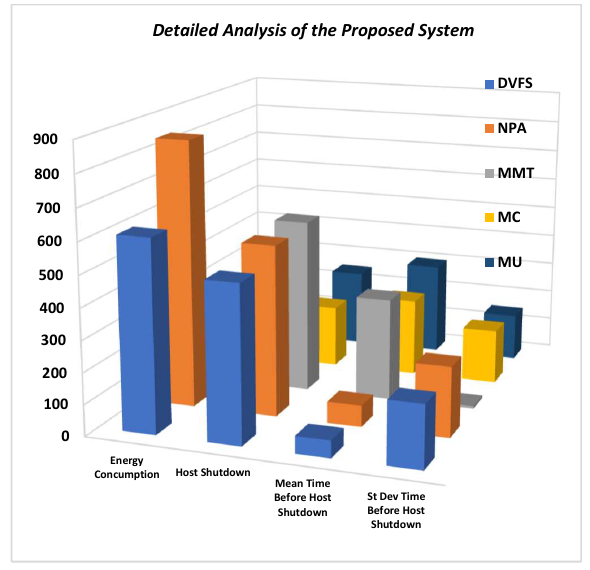
Figure 9. Overall detailed evaluation of the developed system.